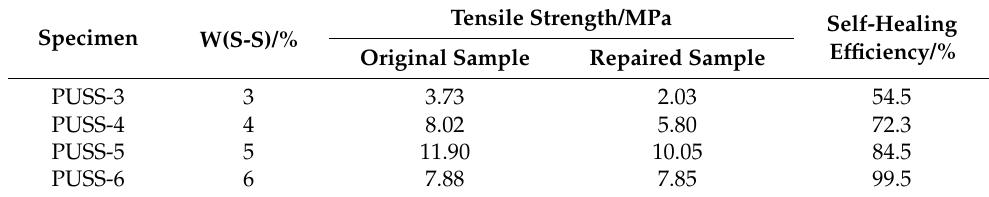
Table 2. Tensile strength and self-repair efficiency of samples with different mass fractions of disul- fide.